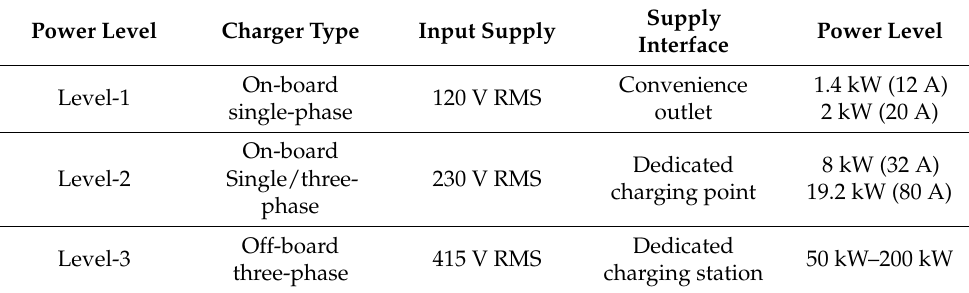
Table 1. Charging power levels, type and supply interface for EV charging [3].